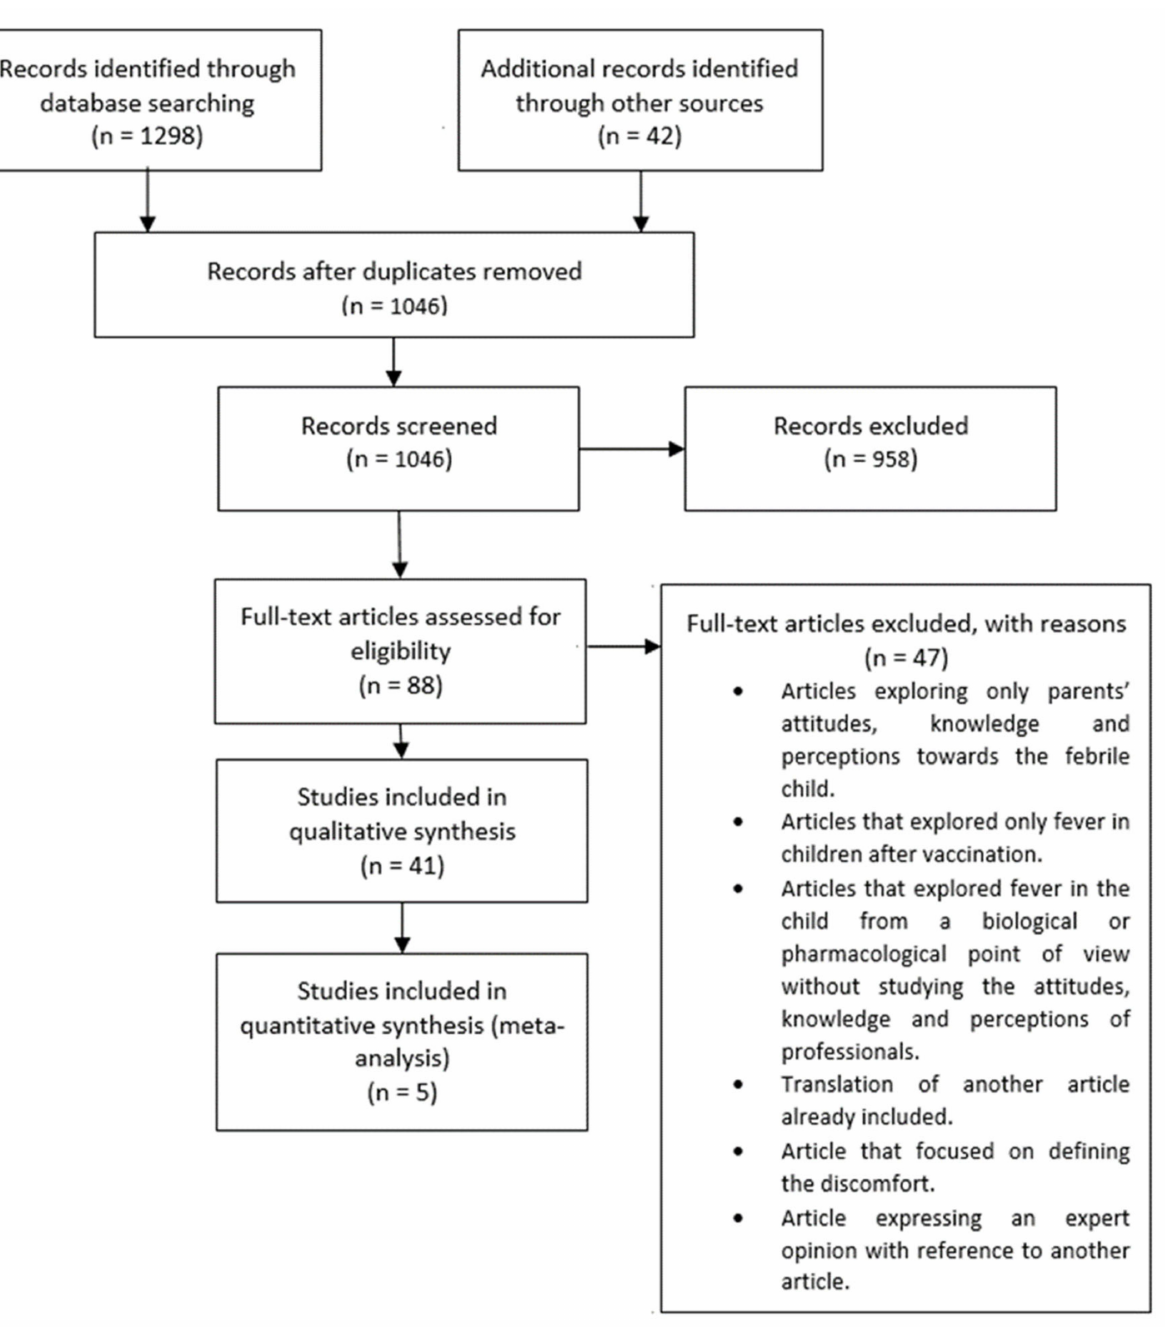
Figure 1. PRISMA flowchart. From: Moher D, Liberati A, Tetzlaff J, Altman DG, The PRISMA Group (2009). Pre- ferred Reporting Items for Systematic Reviews and Meta-Analyses: The PRISMA Statement. PLoS Med 6(6): e1000097.